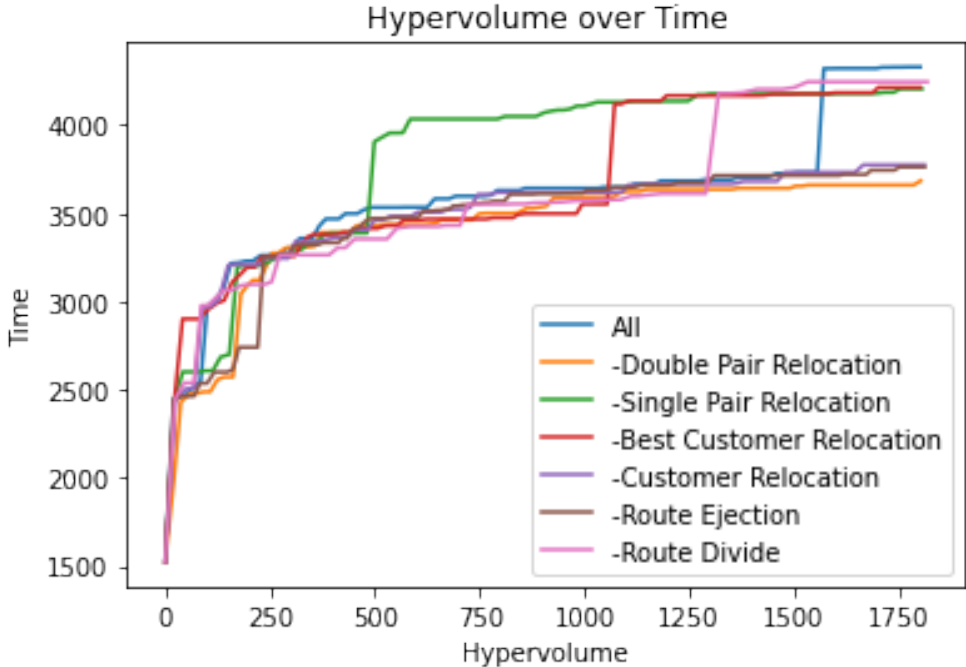
Figure 3. Hypervolume after removing each inter-route operator.